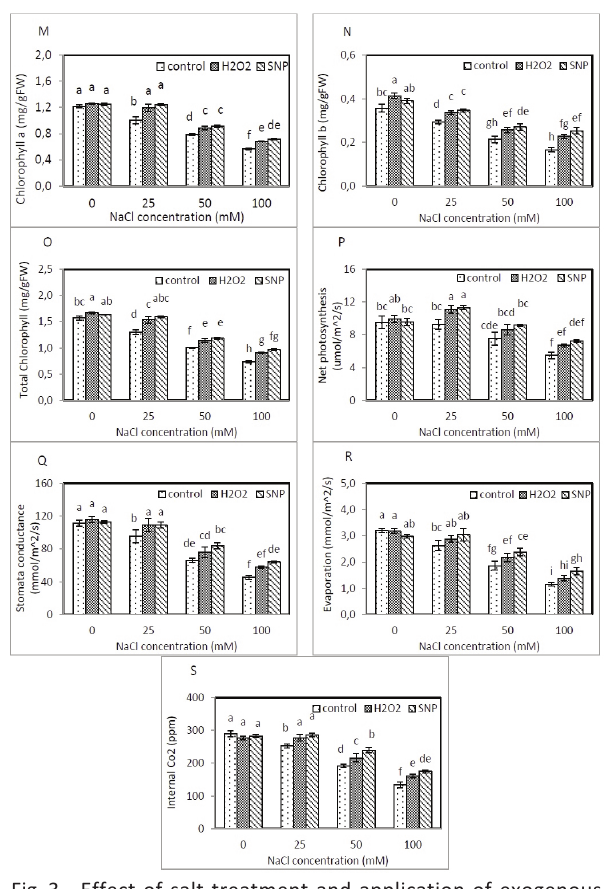
Fig. 3 - Effect of salt treatment and application of exogenous H O and SNP on photosynthesis pigment and attributes 2 2 of tomato plants. Chlorophyll a (M), chlorophyll b (N), total chlorophyll (O), Photosynthetic rate (P), stomatal conductance (Q), transpiration (R) and intercellular CO concentration (S). Data shown are the mean (±SE) of three independent experiments. Significant differences among treatments were determined by Tukey's Test